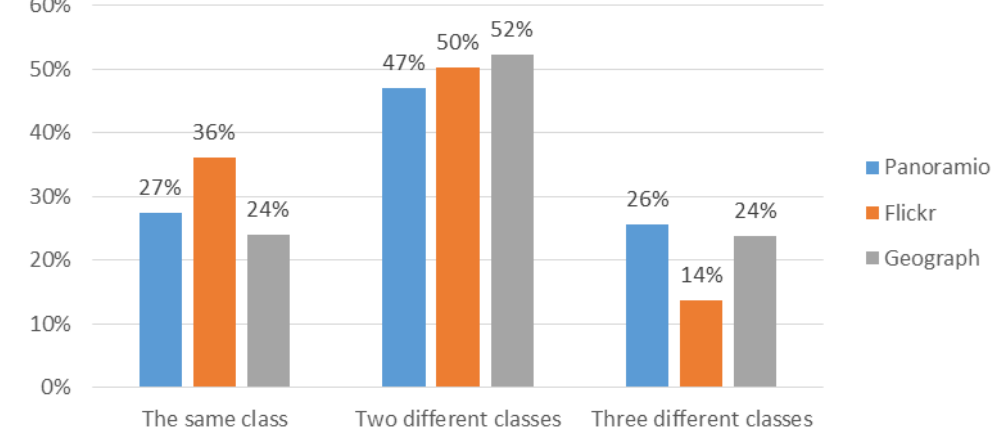
Figure 2. Percentage of photographs to which one class, two classes of three classes were assigned by the seven volunteers, considering the classes “Yes”, “Maybe” or “No”, indicating whether the photographs are useful for extracting land cover information.